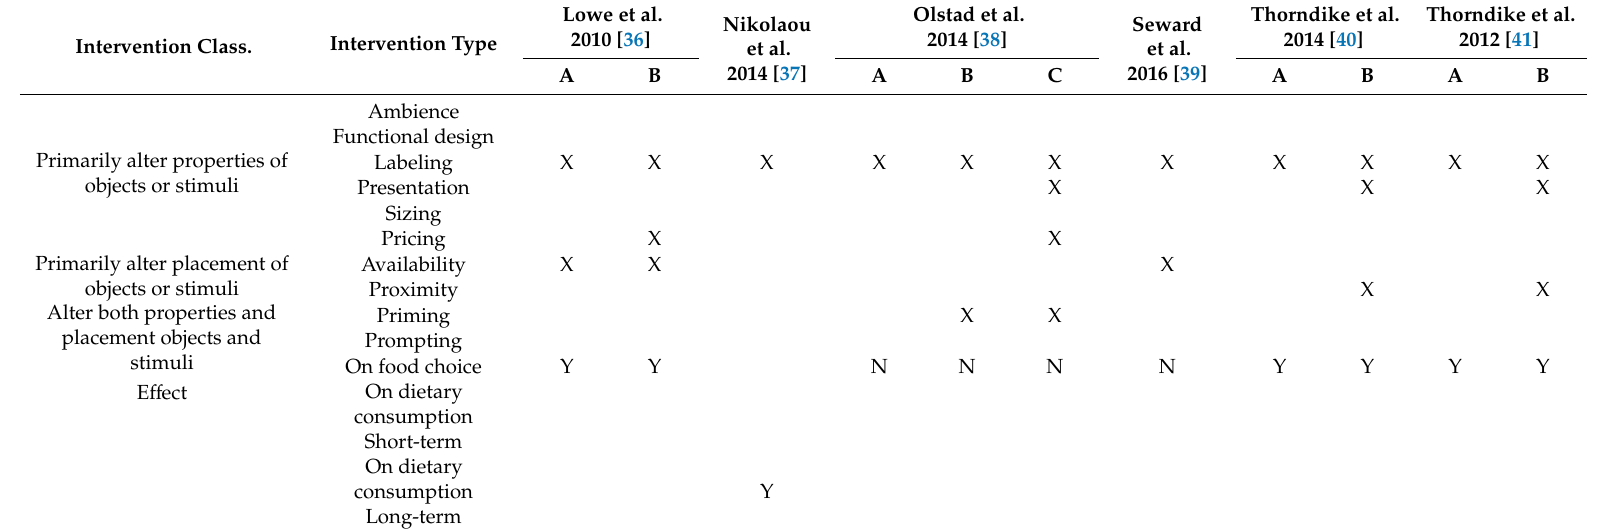
Table 5. Nudging and choice architecture types and e ff ectiveness examined in the included